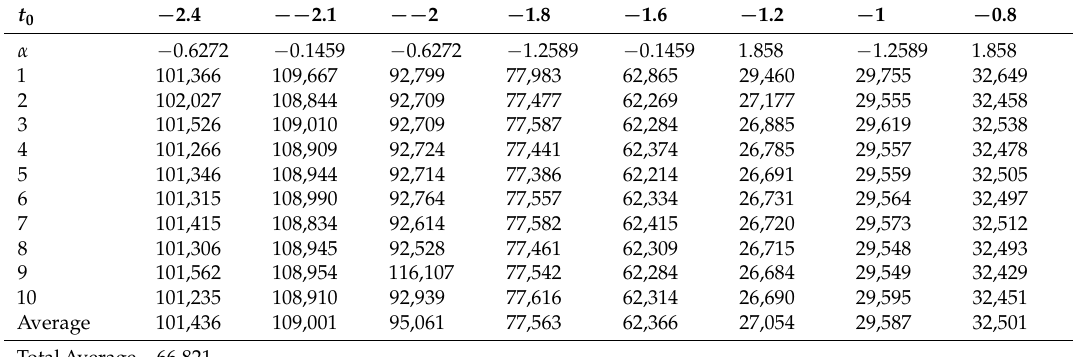
Table 4. Running time for different initial values of Example 2 by our method with test point p = (2.0, 4.0, 8.0).